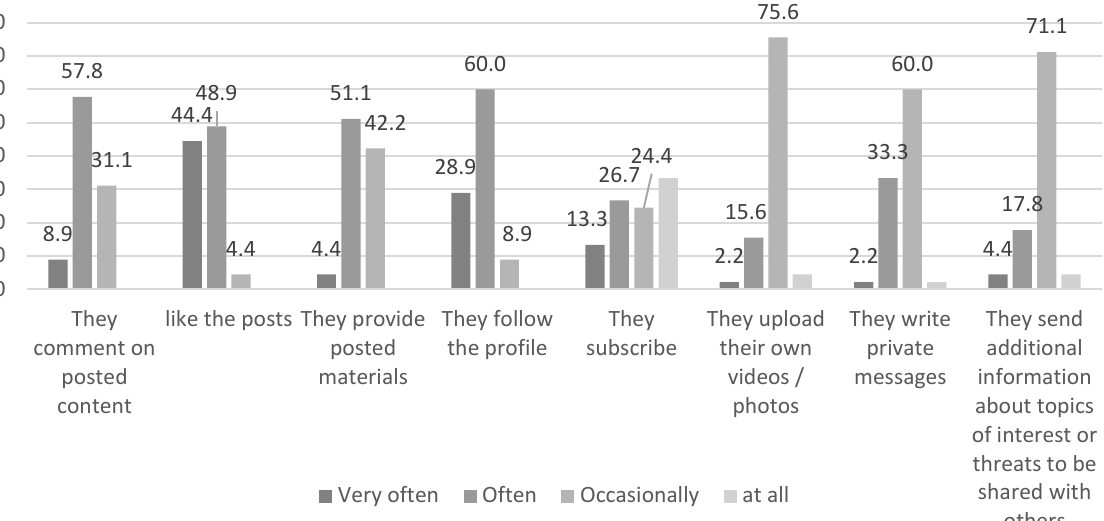
Figure 7. Degree of audience activity in social media. Source: authors’ own elaboration.